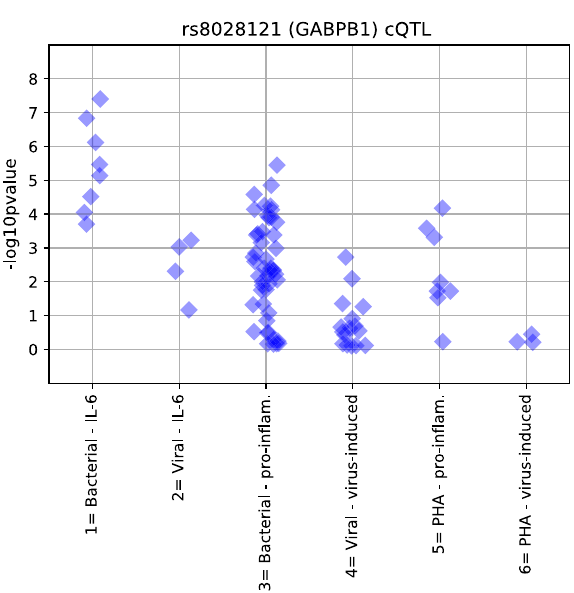
Figure 4. Association of rs8028121 with cytokine-stimulus pairs. The cQTL rs8028121 was associated with IL-6 production in response to bacterial stimuli (x-axis = 1) more strongly than IL-6 production in response to viral stimuli (x-axis = 2), other pro-inflammatory cytokine responses to bacterial stimuli (x-axis = 3), virus-induced cytokine responses to viral stimuli (x-axis = 4), pro-inflammatory cytokine responses to PHA (x-axis = 5), and virus-induced cytokine responses to PHA (x-axis =